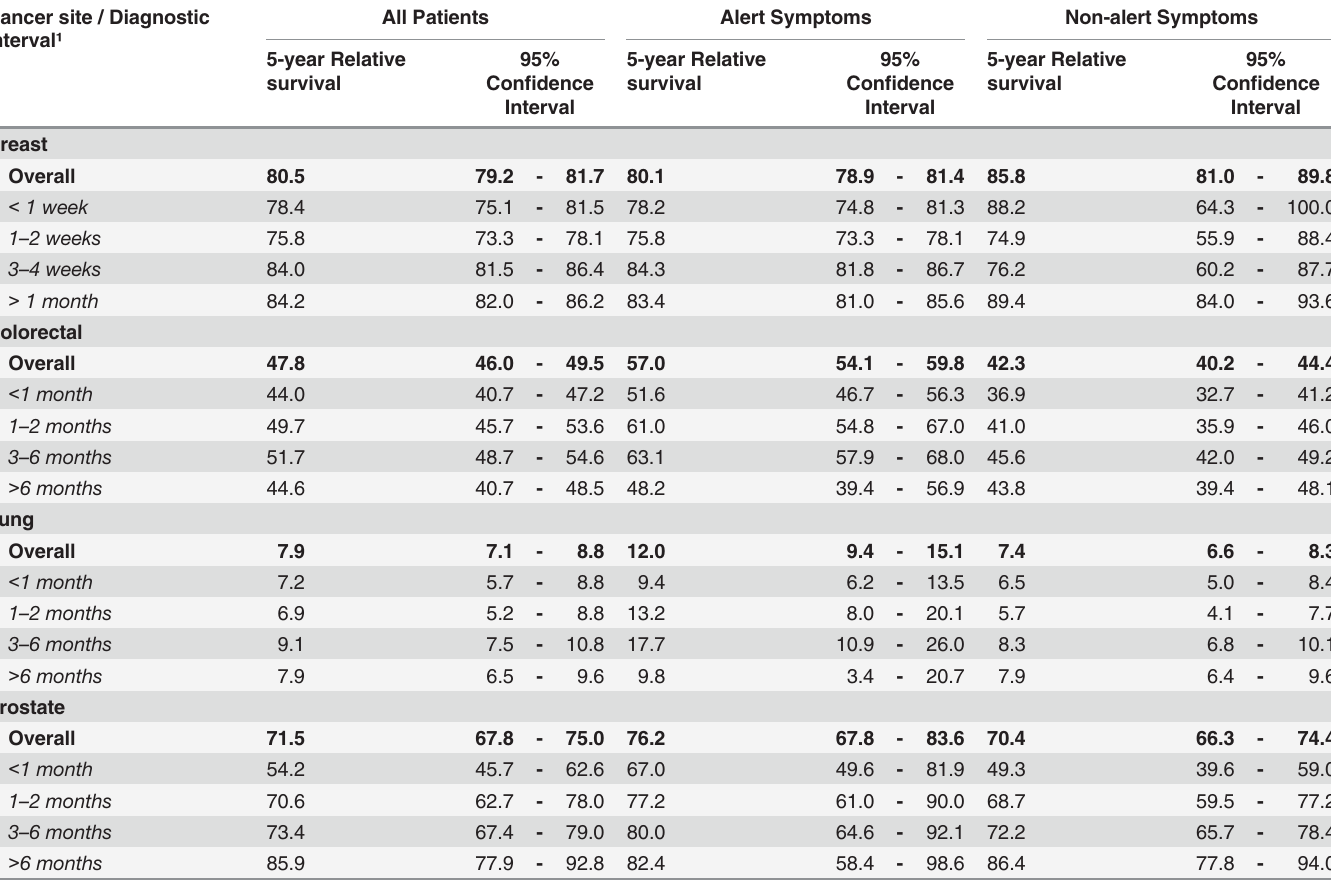
Table 4. Relative survival of cancer patients by site, diagnostic interval ¹ and symptom category ²